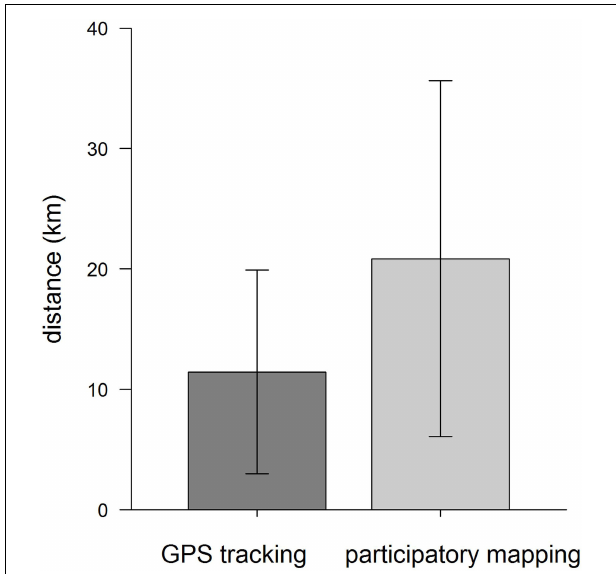
FIGURE 5 | Average distances ( ± SD) recorded via GPS tracking ( n = 17) and participatory mapping ( n = 112).